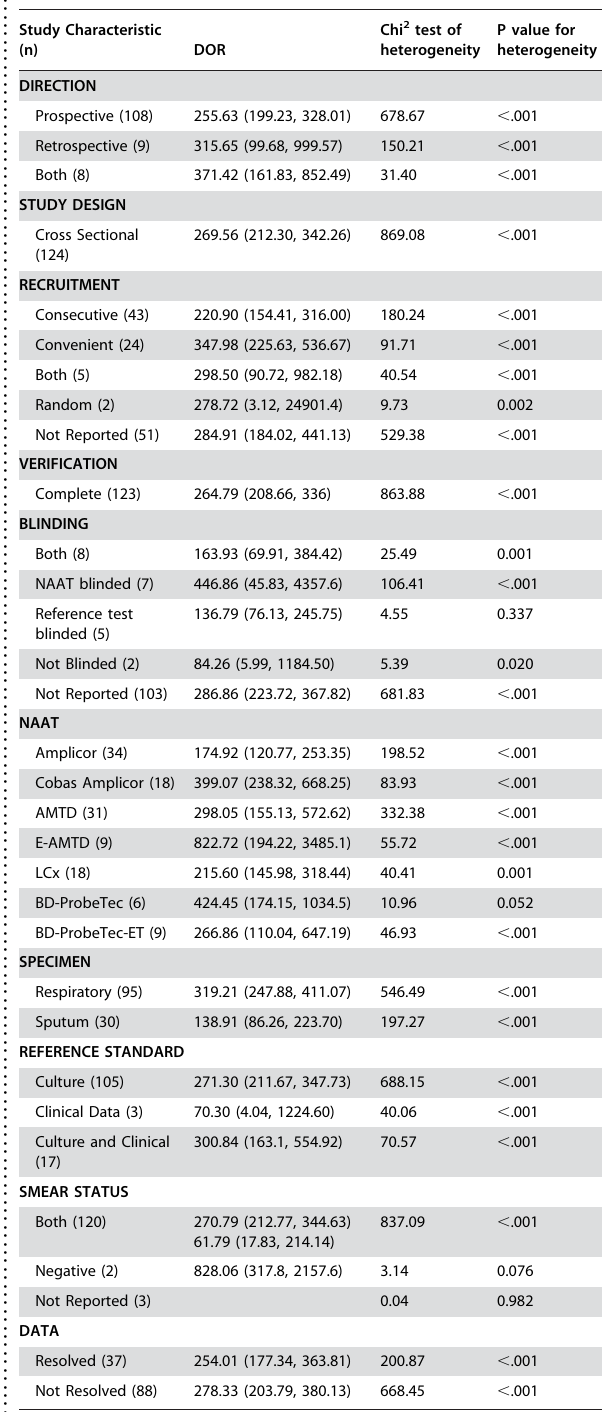
Table 4. Diagnostic Odds Ratio (DOR) Estimates